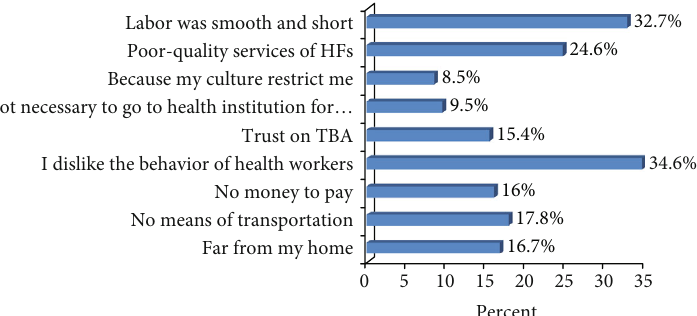
Figure 6: Reasons for preferring home delivery ( n = 200 ) in Jimma Arjo District, Oromia, Ethiopia, 2018. ∗ More than one possible answer was used.